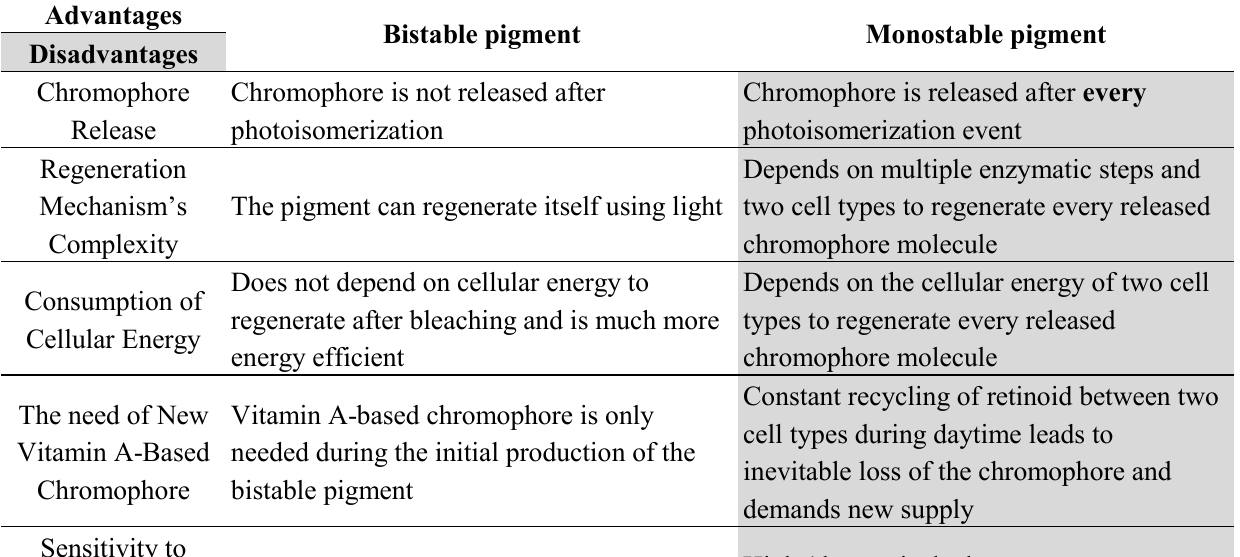
Table 3. Comparison of bistable pigments and monostable